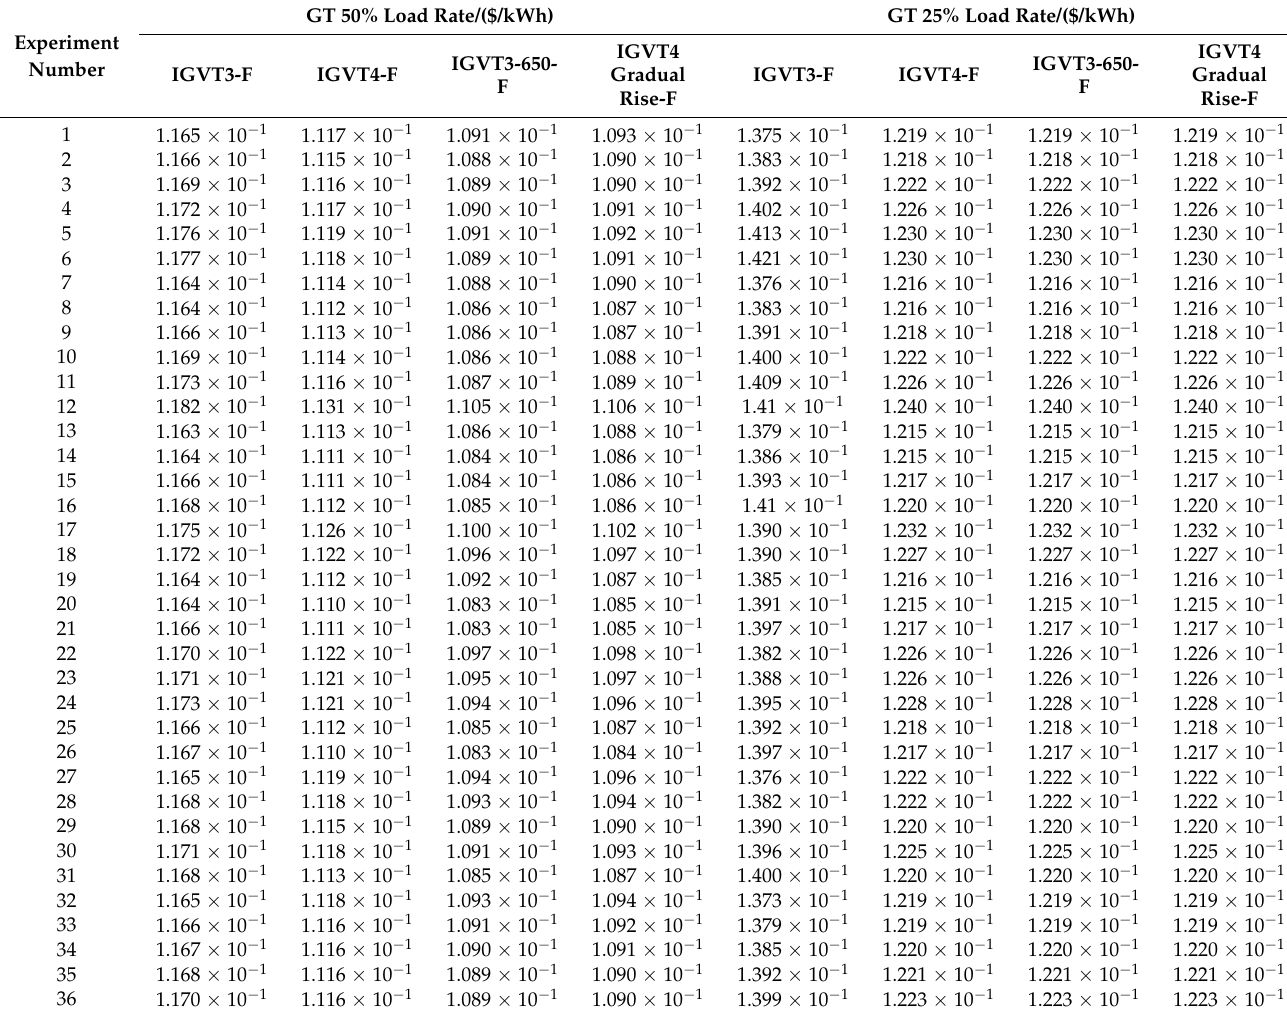
Table 7. Orthogonal test results (GT 50% and 25% load